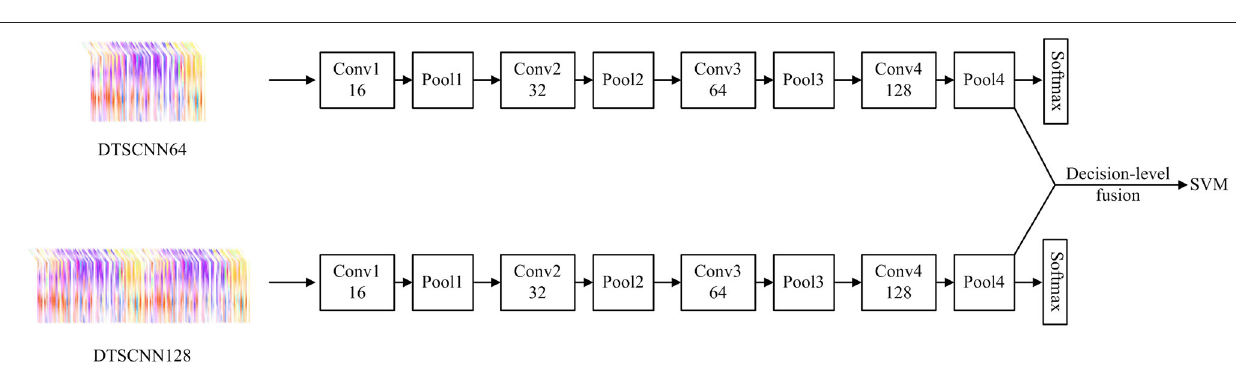
FIGURE 4 | Dual Temporal Scale Convolutional Neural Network